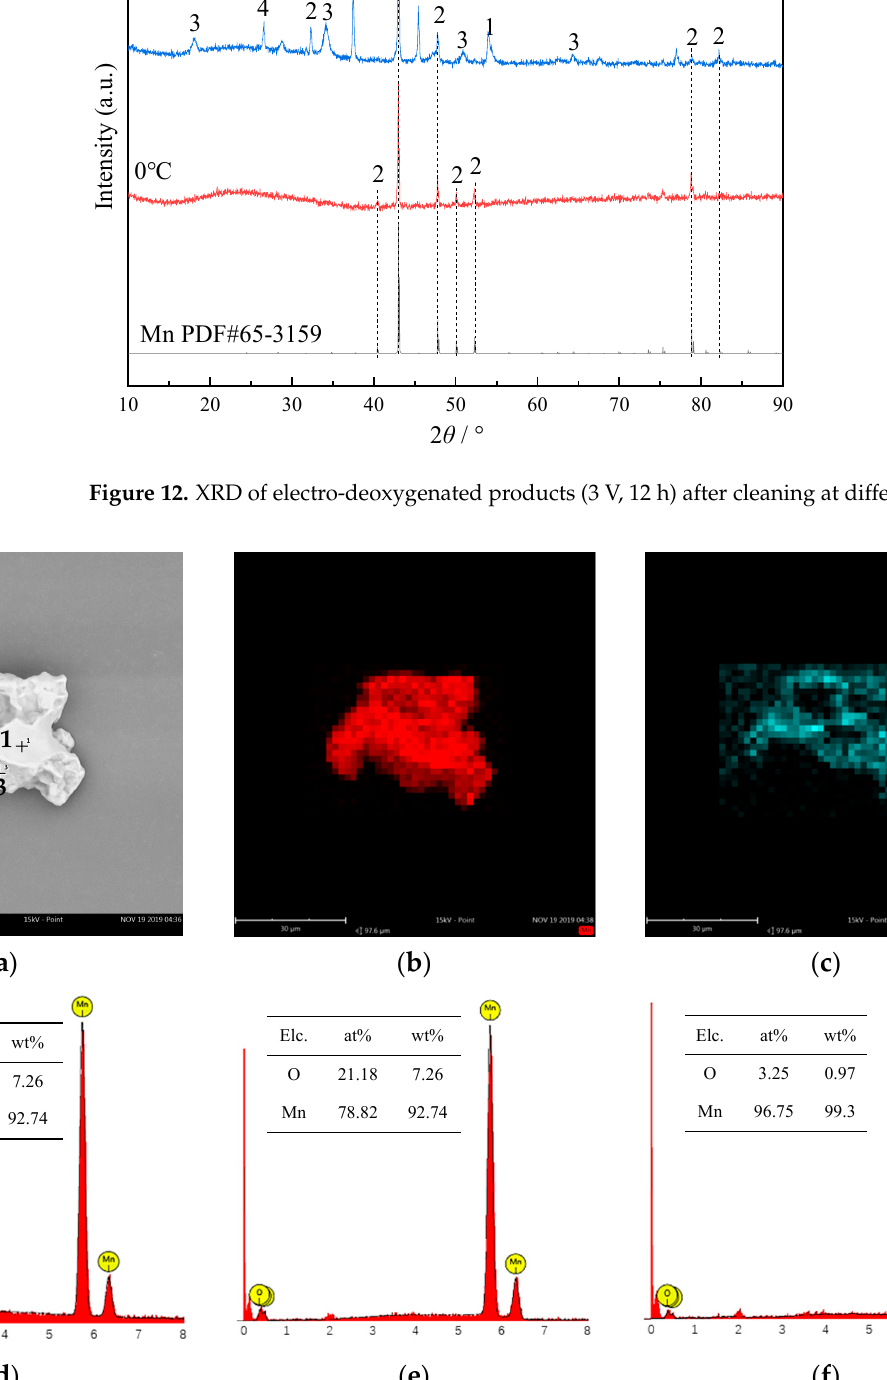
Figure 13. Electro deoxidation product surface scan: ( a – c ) and EDS of ( d ) point 1; ( e ) point 2; ( f ) point 3.